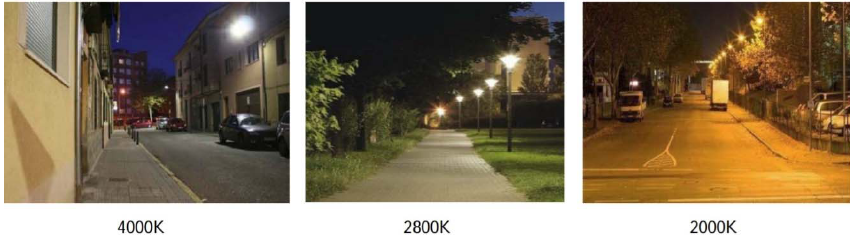
Figure 2. Public lighting of Baeza with three different temperatures [24].